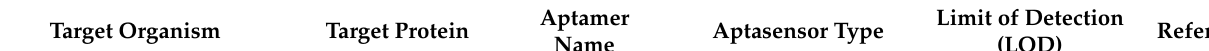
Table 1. The summary of the aptamers and aptasensors developed against various